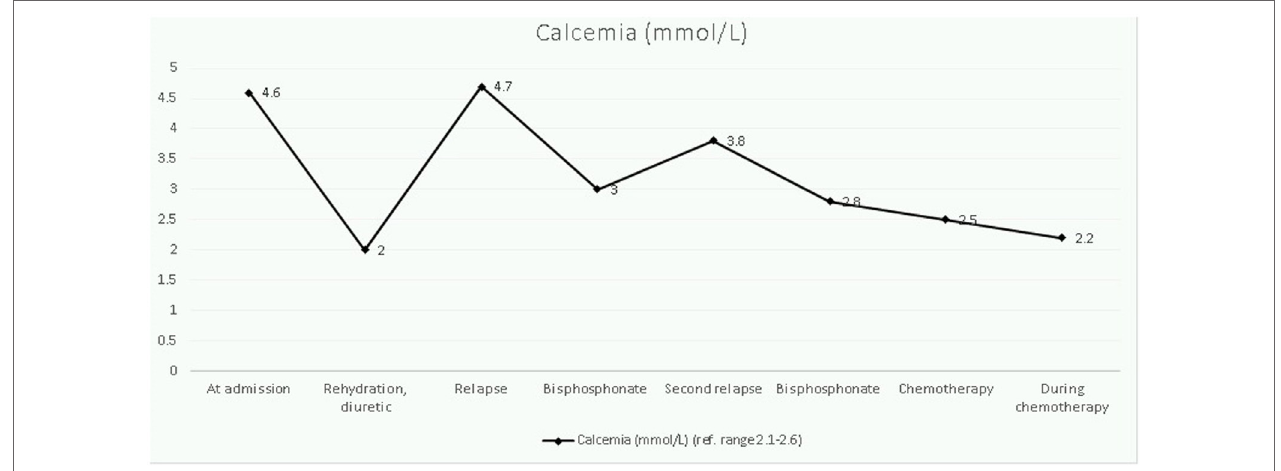
FIgURe 2 | Longitudinal evolution of